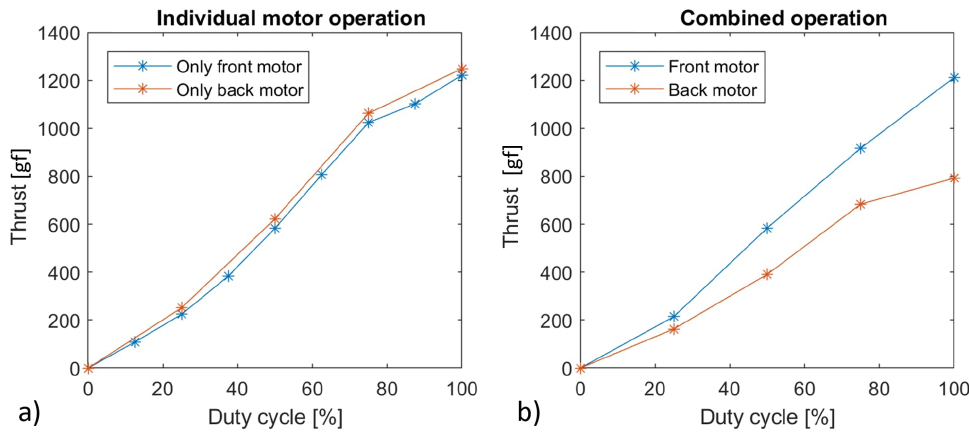
Figure 5. Thrust output from front and back rotors when ( a ) Front and back rotor are run individually and ( b ) both rotors are simultaneously